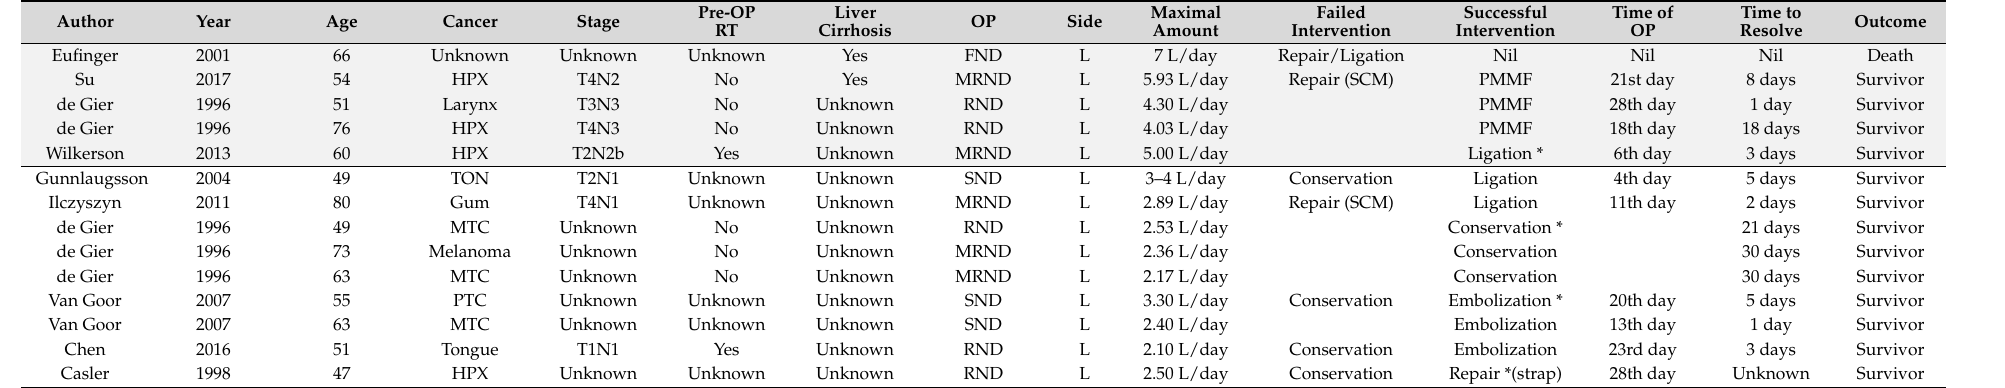
Table 1. Studies including cases with high and massive volume of chylous leakage in a global